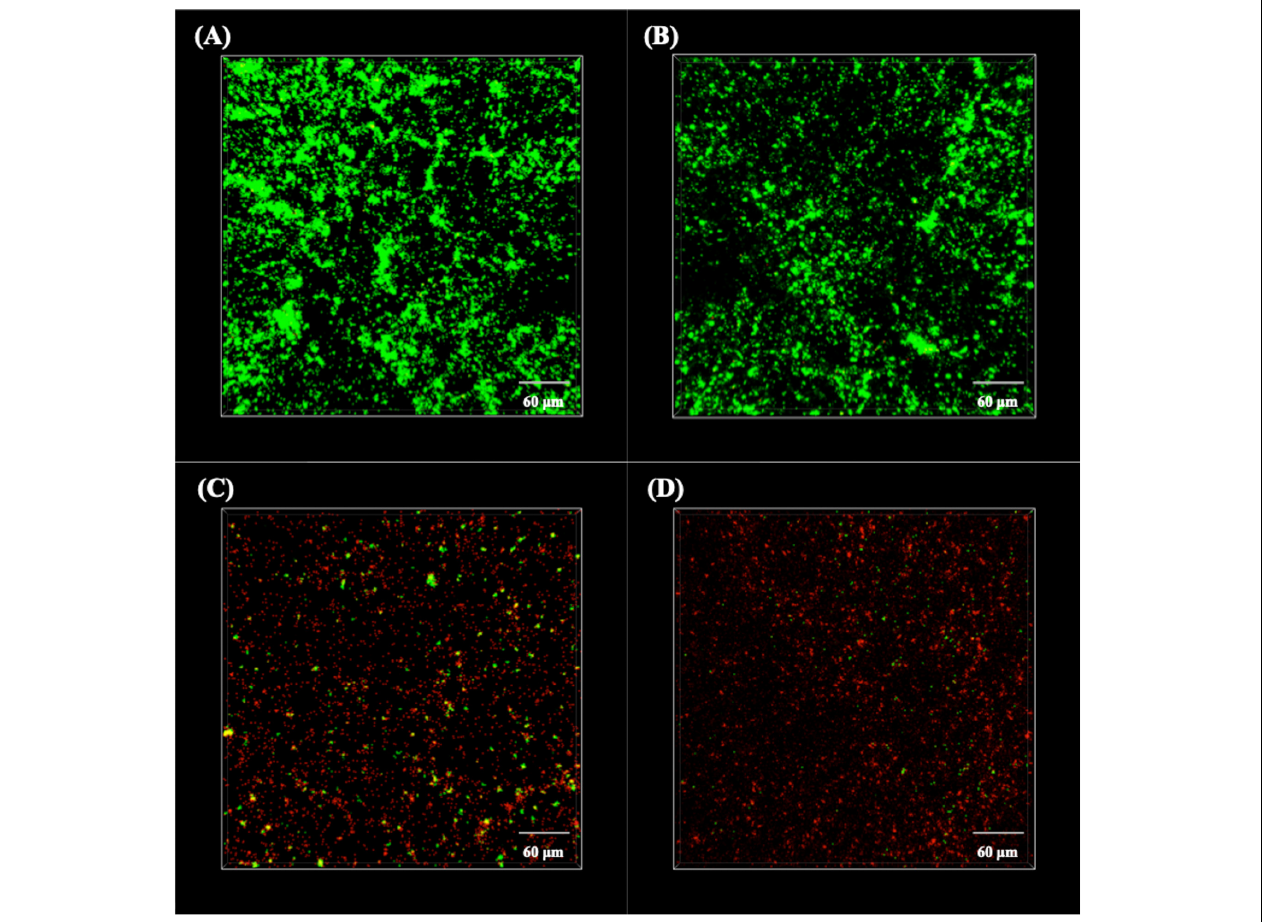
FIGURE 4 | CLSM images of live/dead stained Pseudomonas aeruginosa biofilms on the surfaces of (A) 304L BM, (B) 304L WZ, (C) 304L-Cu BM, and (D) 304L-Cu WZ specimens after 14 days of immersion test. CLSM, confocal laser scanning microscopy; BM, base metal; WZ, welding zone.